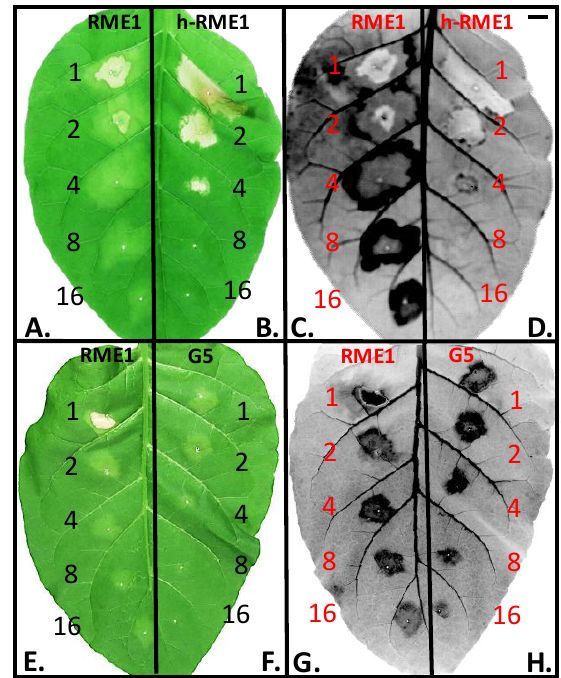
Figure 5. Macroscopic symptoms induced in tobacco leaves by RME1 infiltration at 4 days post-infiltration (dpi) before (RME1 in A , C , E , G ) and after alkaline hydrolysis (h-RME1 in B , D ) and pentagalloyl glucose infiltration (G5 in F , H ). Tobacco leaves were infiltrated with a range of PP concentrations: 0.19% PP concentration (1) diluted twice (2), 4 fold (4), 8 fold (8), and 16 fold (16). G5 in F,H was infiltrated at 148 mg L − 1 (1) and diluted following the same range. Tobacco leaves were examined under bright light ( A , B , E , F ) and UV light ( C , D , G , H ). Bar 1.5 cm.